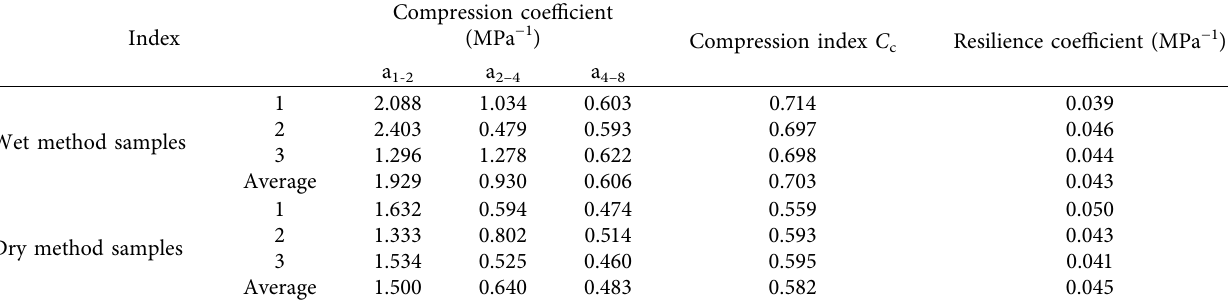
Table 9: Compression parameters of different